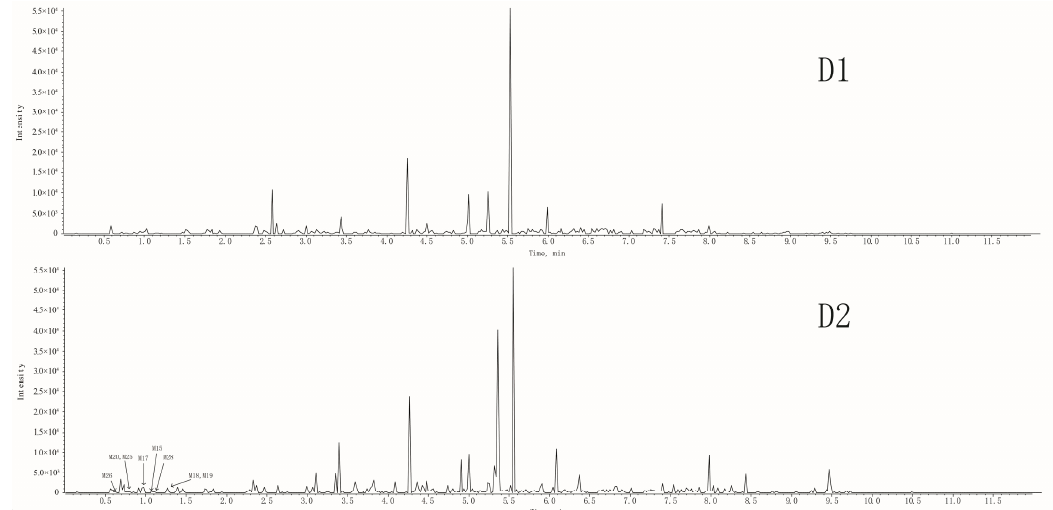
Figure 2. Total ion chromatograms of complanatuside in rat samples; ( A1 ) blank plasma, ( A2 ) plasma sample after oral administration; ( B1 ) blank bile, ( B2 ) bile sample after oral administration; ( C1 ) blank stool, ( C2 ) stool sample after oral administration; ( D1 ) blank urine, ( D2 ) urine sample after oral administration. Table 1. Accurate mass measurements and metabolite description of